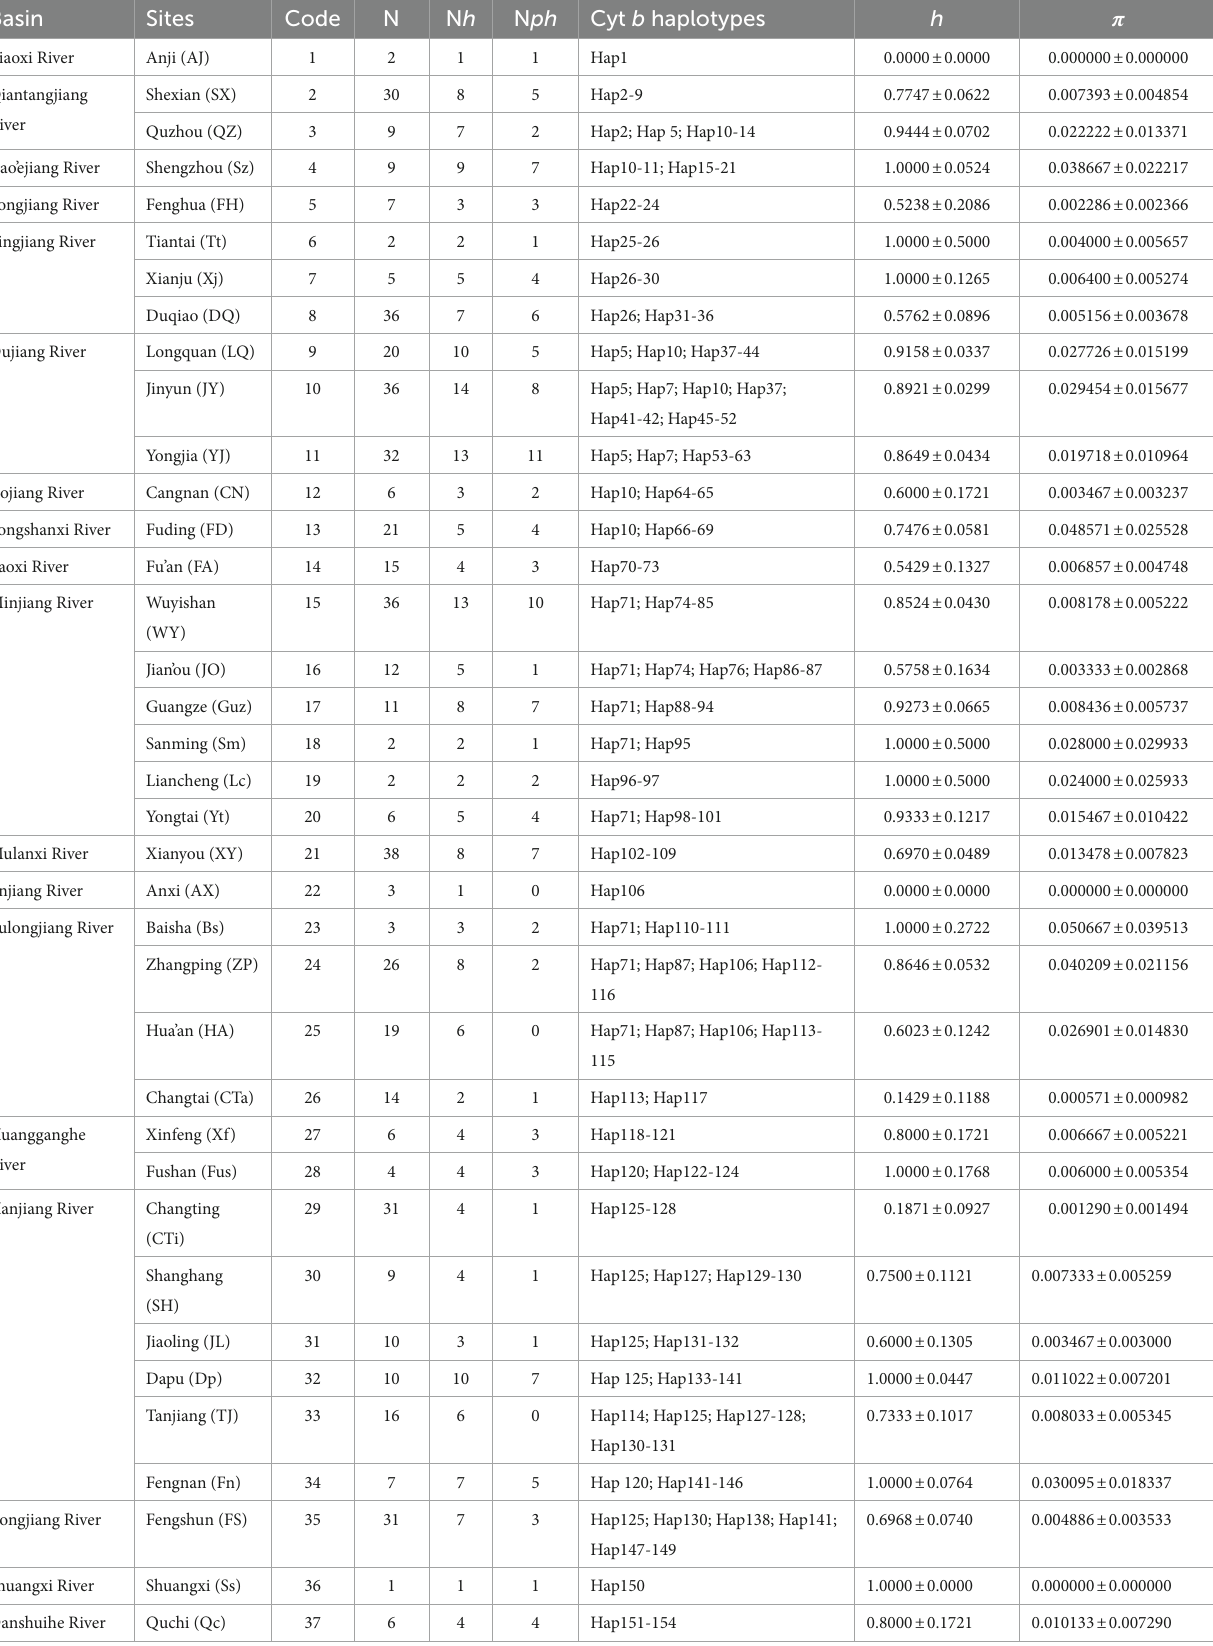
TABLE 1 Sampling information for the 62 populations of O. acutipinnis-evolans complex used in this study. Basin Sites Code N N h N ph Cyt b haplotypes